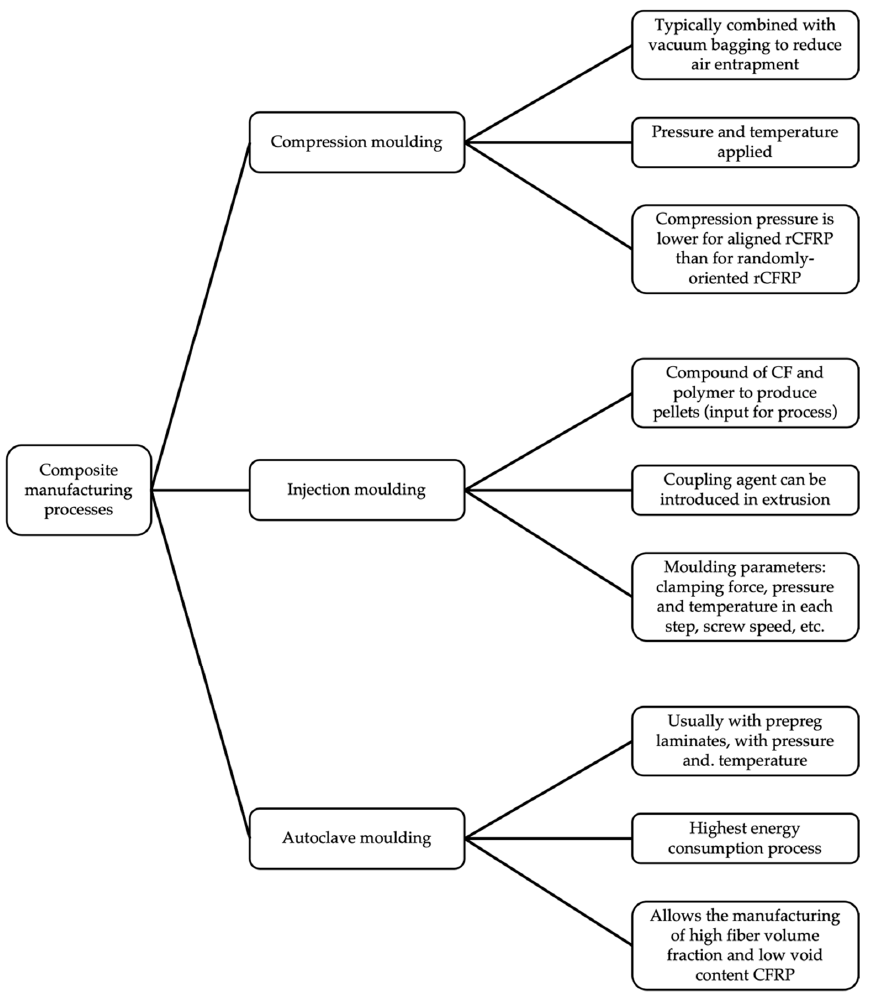
Figure 5. Most common composite manufacturing processes for rCFRP (adapted from Meng et